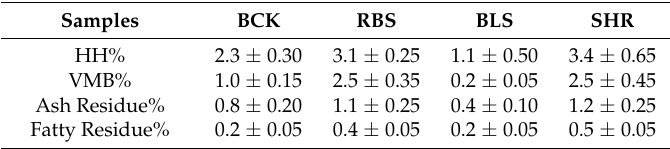
Table 2. Vegetable matter analysis of the samples.